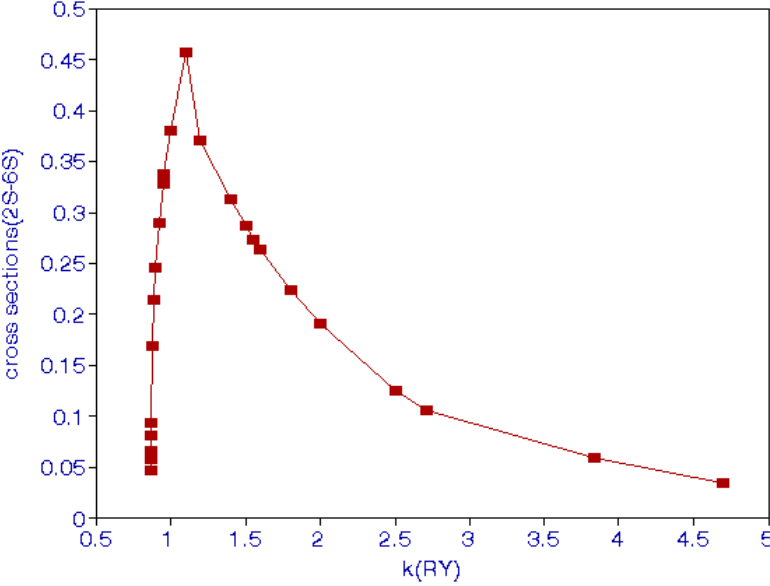
, as shown by the solid line in Figure 2.